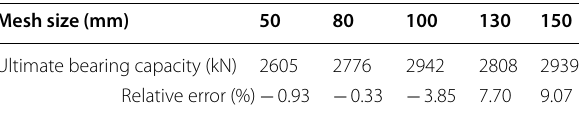
Table 2 Ultimate bearing capacity and calculation time with different mesh